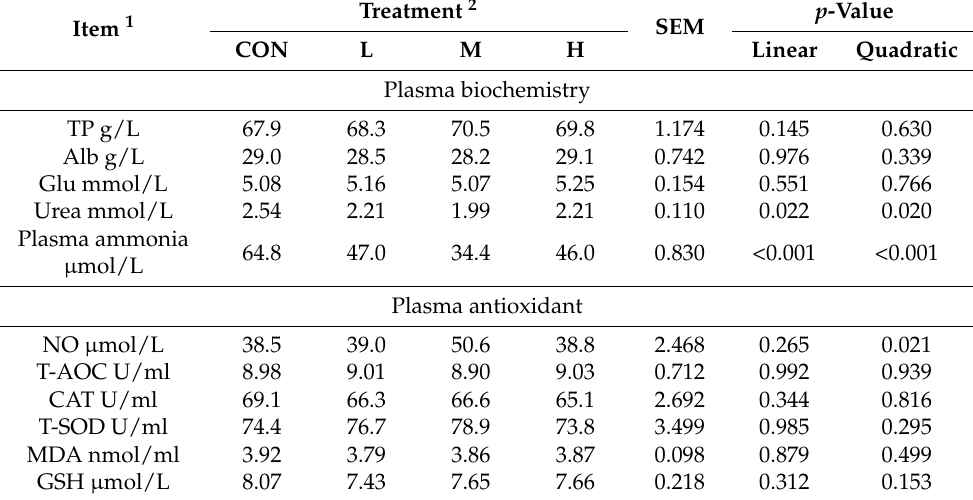
Table 4. Effect of supplementation with N-carbamylglutamate (NCG) on the plasma biochemistry and antioxidants in fattening Holstein bulls.